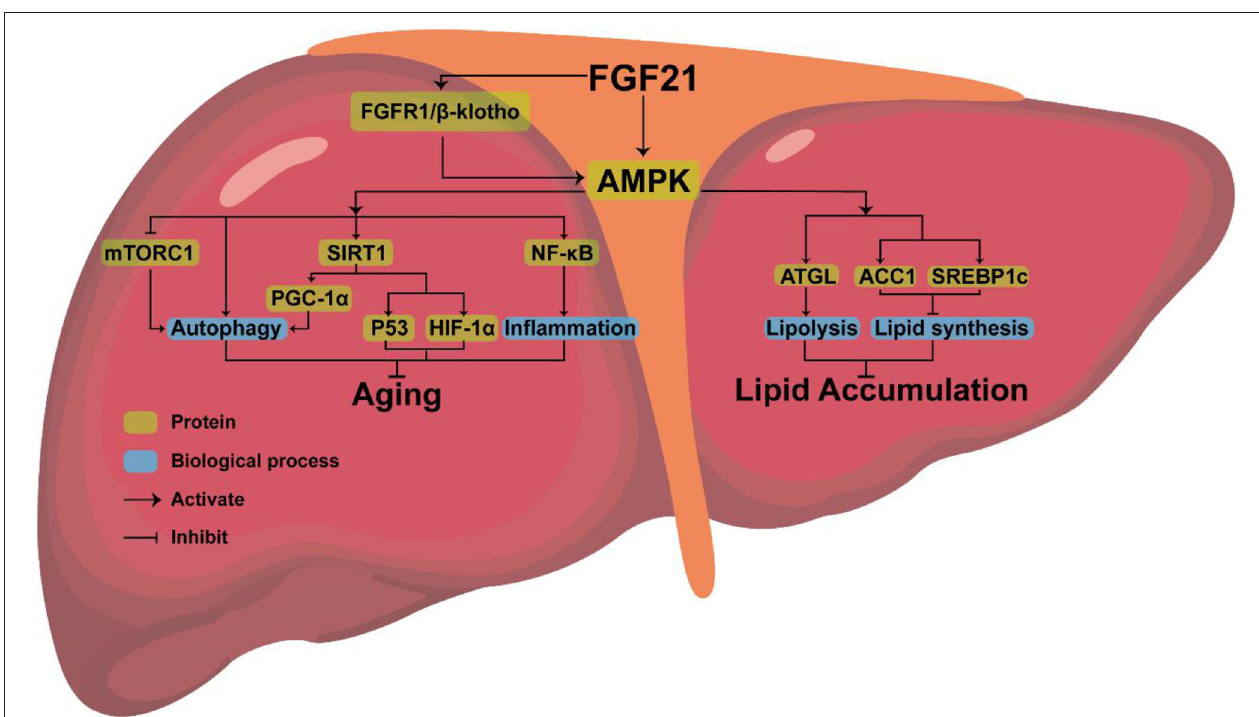
FIGURE 2 | The possible mechanism of FGF21 simultaneous regulation of aging and metabolism.